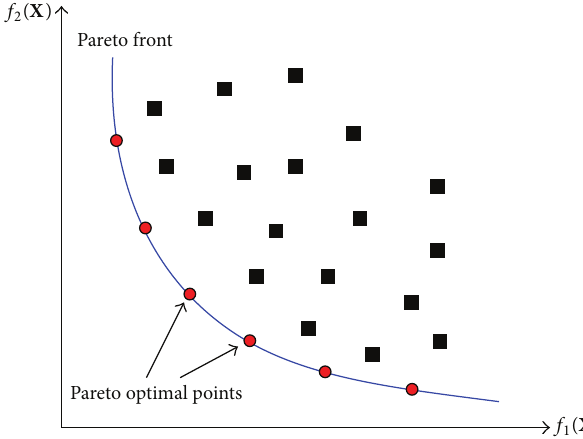
Figure 3: Illustration of the Pareto optimal points and the Pareto front for a problem with two objective